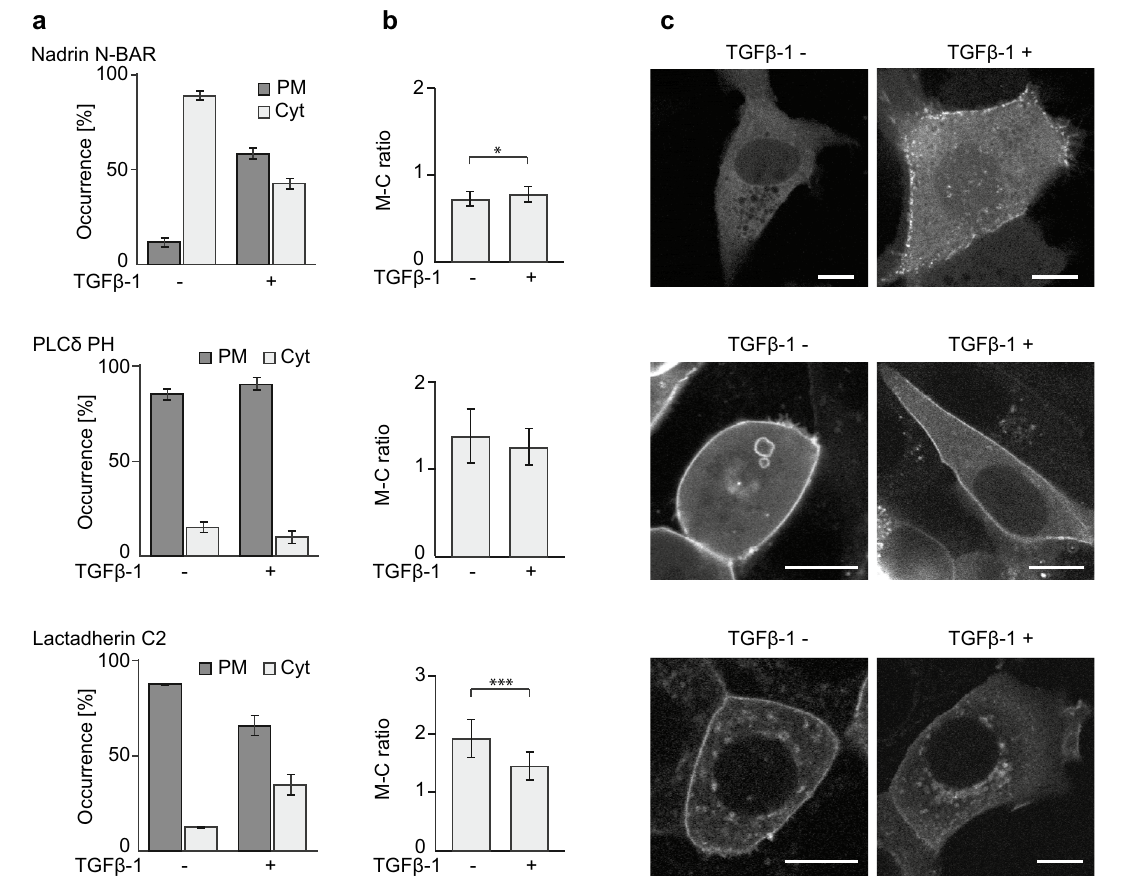
Figure 2. EMT promotes changes in membrane curvature. Comparison of MCF7 cells expressing Nadrin- YFP (Nadrin N-BAR), PLCdelta-GFP (PLCδ PH) and Lact-GFP (Lactadherin C2) domains treated or not with TGFβ-1 for 2 days. Data shown comes from merging two or three independent biological replicates of each protein (for separate analysis of all replicates see Fig. S2). ( a ) Comparison of ratios between cells with cytoplasmic (Cyt) and plasma membrane (PM) localization (Nadrin N-BAR n ≥ 93, PLCδ PH n ≥ 65, Lactadherin C2 n ≥ 168), error bars represent ± 0.5 SD. ( b ) Comparison of membrane-to-cytoplasm ratios (M-C Table S2). ( c ) Representative images of all tested conditions. Scale bar 10